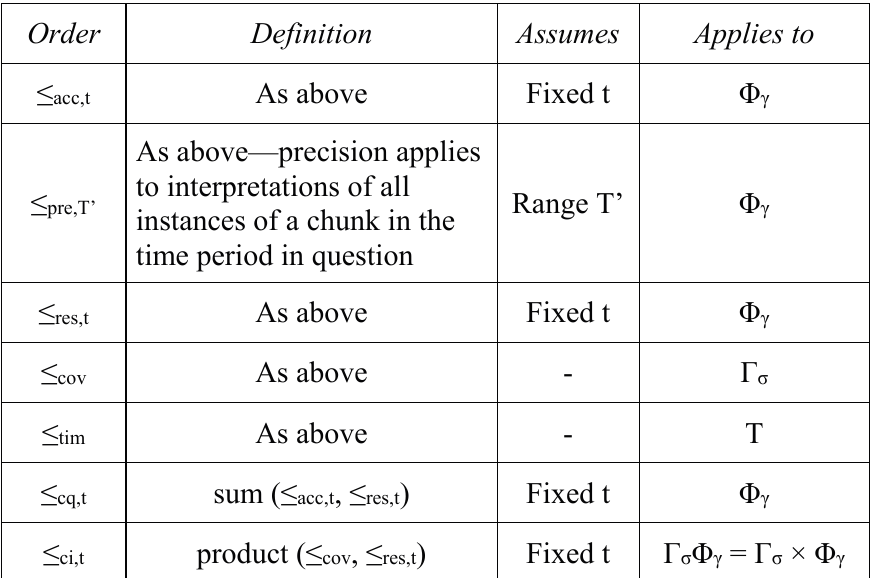
Table 1. Combined chunk partial